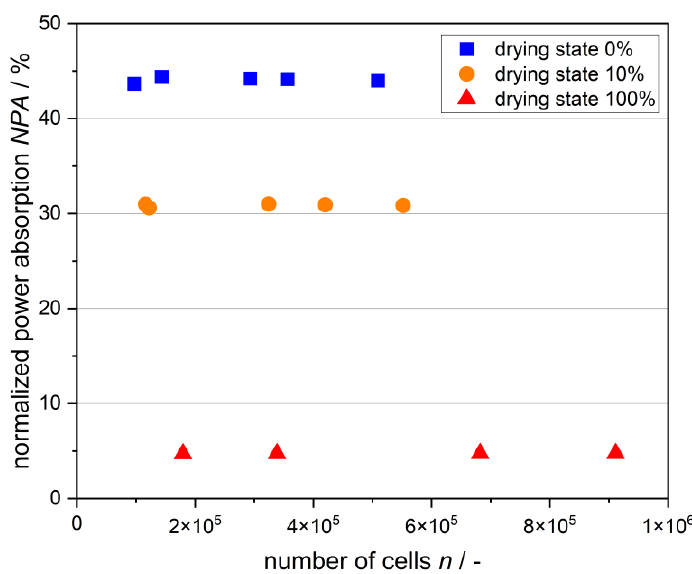
Figure 5. NPA at 2.45 GHz displayed as a function of the number of mesh cells in the electromagnetic simulations for various drying